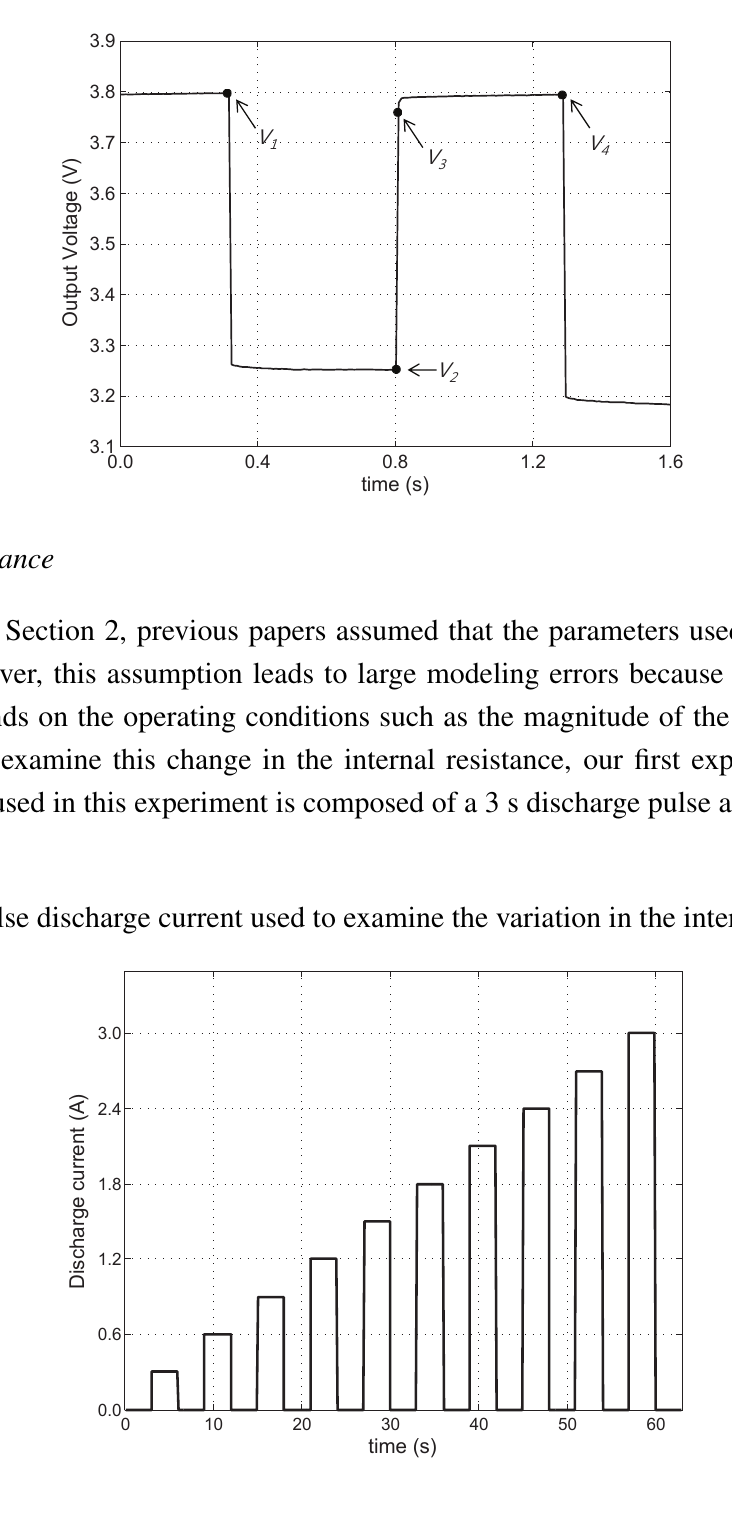
Figure 3. Output voltage when a discharge current of 1.0C is applied in 0.5 s intervals.